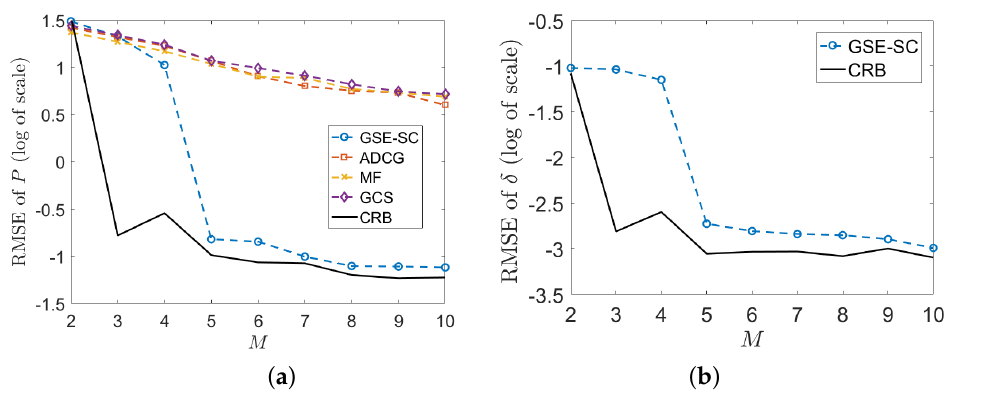
Figure 5. RMSEs of P and δ versus M . ( a ) RMSE of P ; ( b ) RMSE of δ